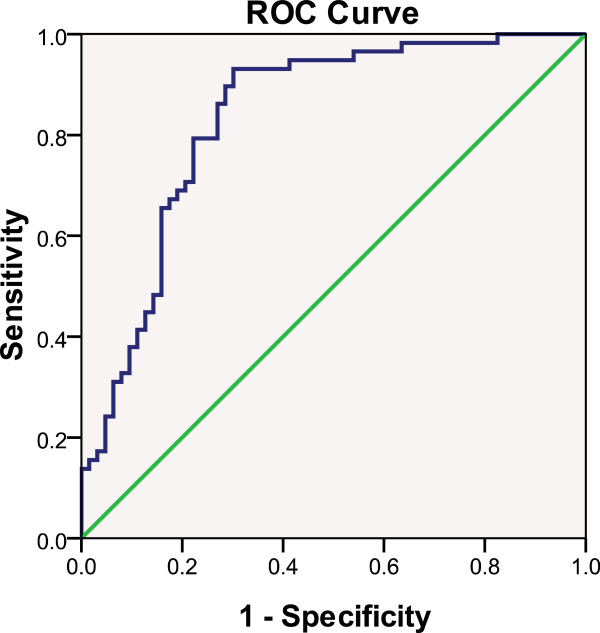
Area under ROC curve of the predicted probability of IgAN with “FIB + sIgA + Manifestation” combination from discriminant analysis. Area under the ROC curve for predicting immunoglobulin A nephropathy (IgAN) with the equation derived via discriminant analysis, which includes the “fibrinogen (FIB) + serum immunoglobulin A level (sIgA) + manifestation” combination. The state variable is IgAN.